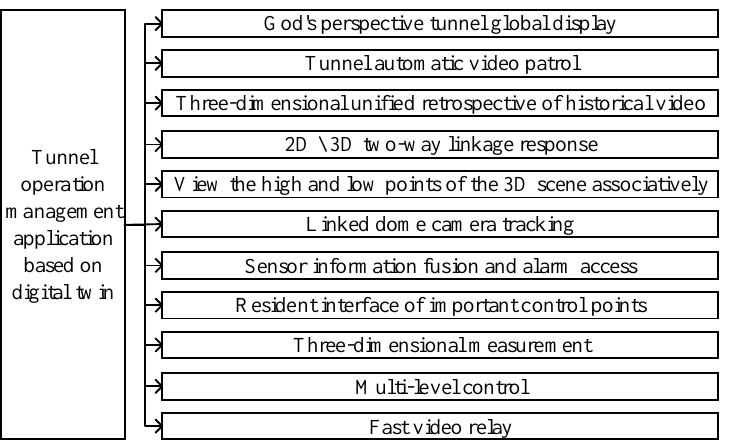
Figure 8. Example of tunnel traffic simulation results.